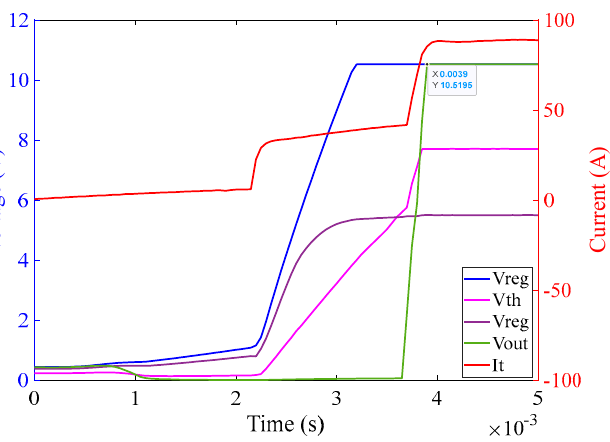
Figure 23. Activation time of the 1 Ω burden circuit at 60 A(rms) input current with 0° phase angle.